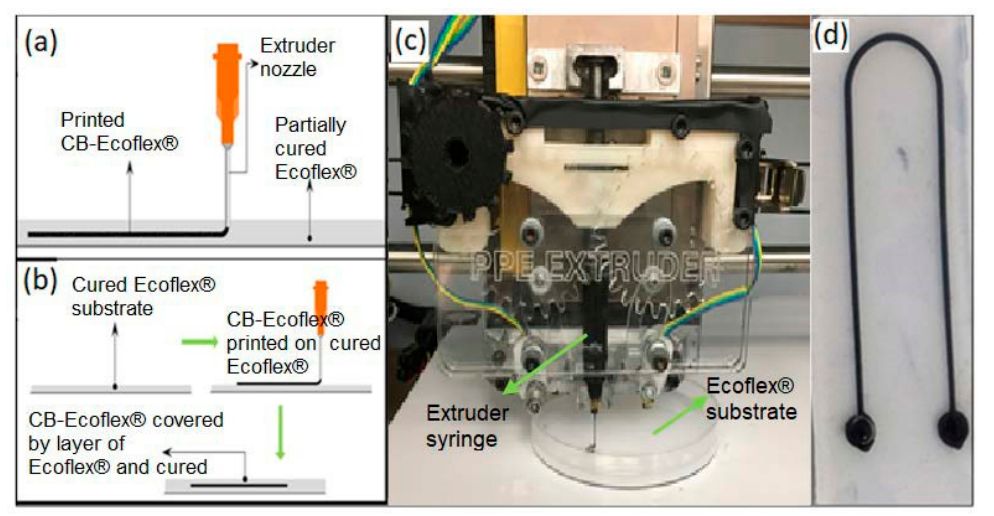
Figure 1. ( a ) A DIY extrusion printer used to print the CB nanocomposite and the fabrication techniques using, ( b ) “embedded” printing, ( c ) “layer-upon-layer” printing and ( d ) a photograph of a printed